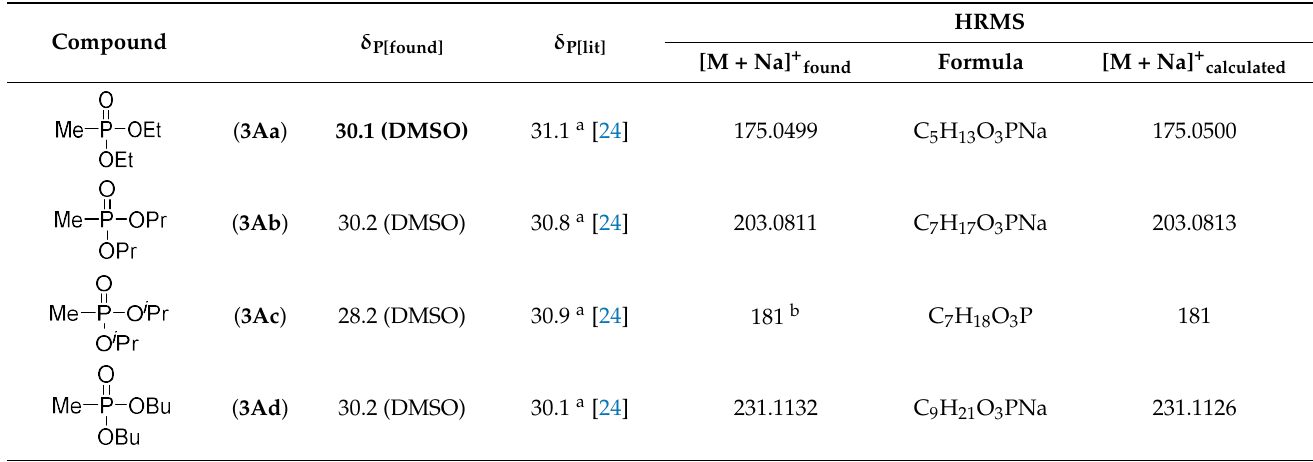
Table 8. Identification of the diesters ( 3A – d/a – d ).